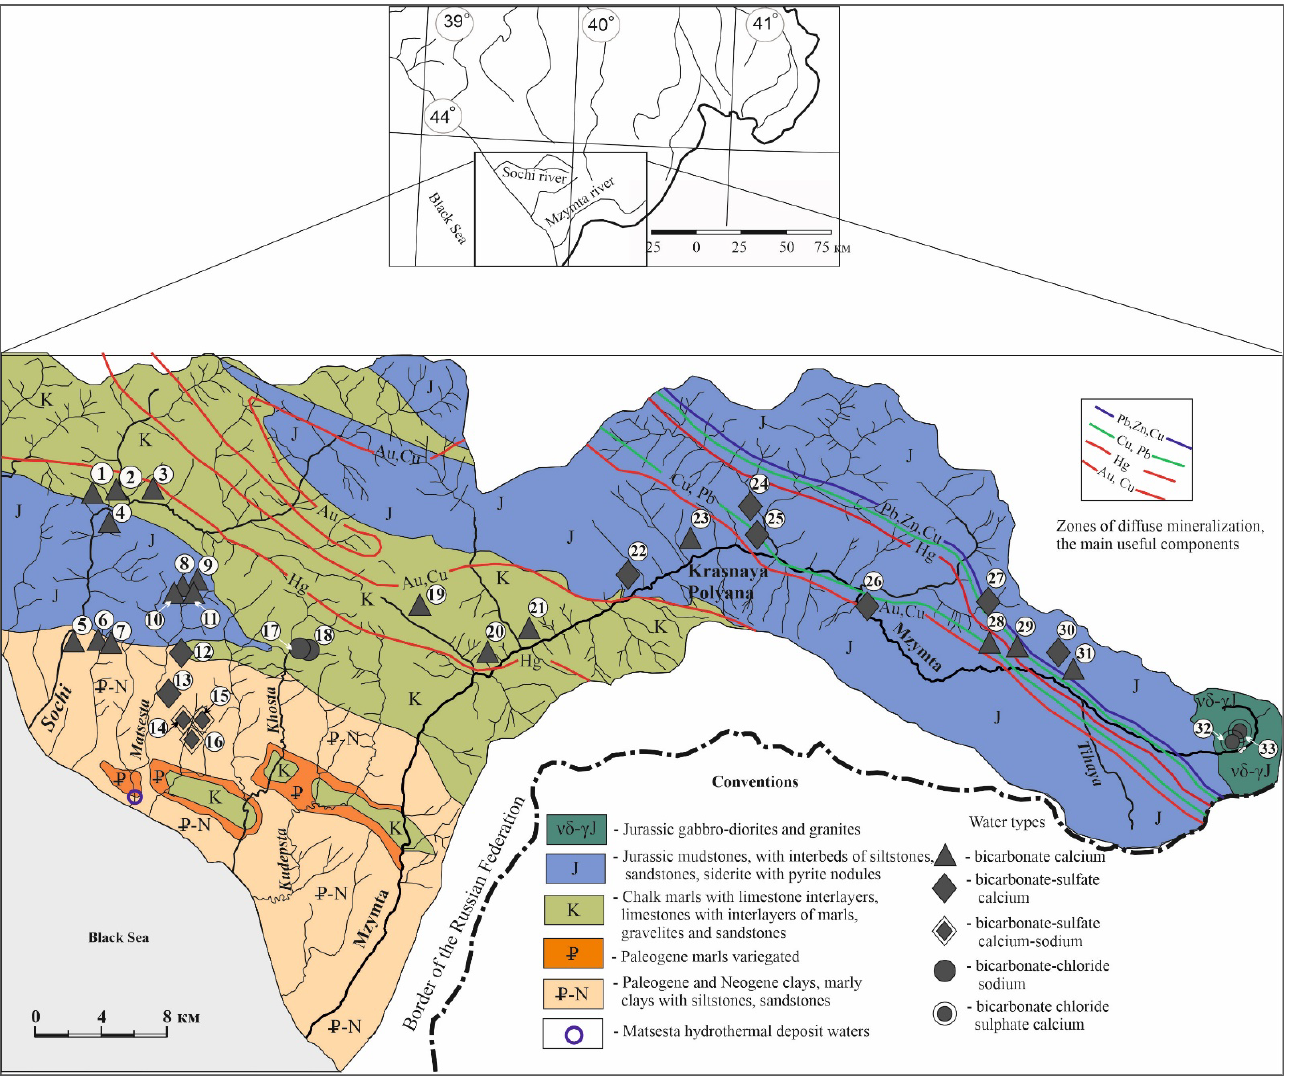
Figure 1. Geological map of the Mzymta and Sochi River valleys and groundwater outlets surveyed. The source of the Sochi River is on the southern slope of the Greater Caucasus Moun- tains near the 1813-meter-high Chura Mountain [34]. The river flows into the Black Sea in the central district of Sochi. The river is 45 km long and has a basin area of 296 km 2 . The mean annual discharge in its middle reaches about 17 m3/s and the annual fluctuations in the river level reach 2.32 m.